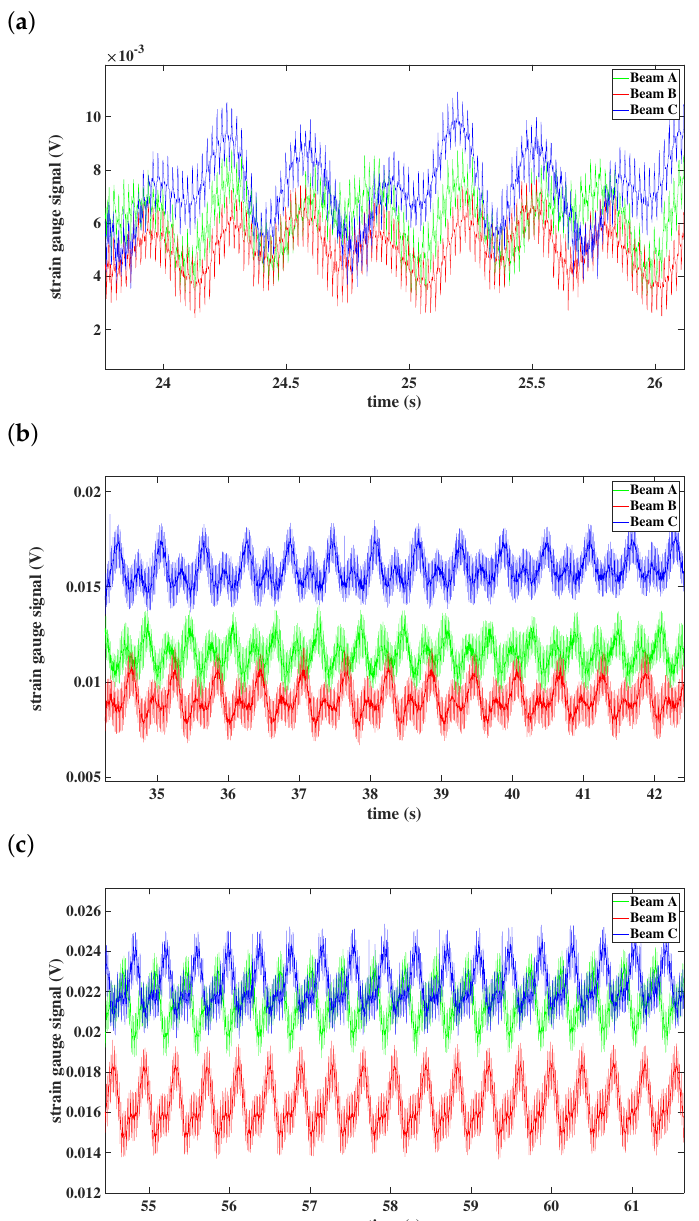
Figure 17. Time histories of individual beams: ( a ) preset angle 5 ◦ and angular speed 50 rpm, ( b ) preset angle 5 ◦ and angular speed 100 rpm, ( c ) preset angle 5 ◦ and angular speed 150 rpm.